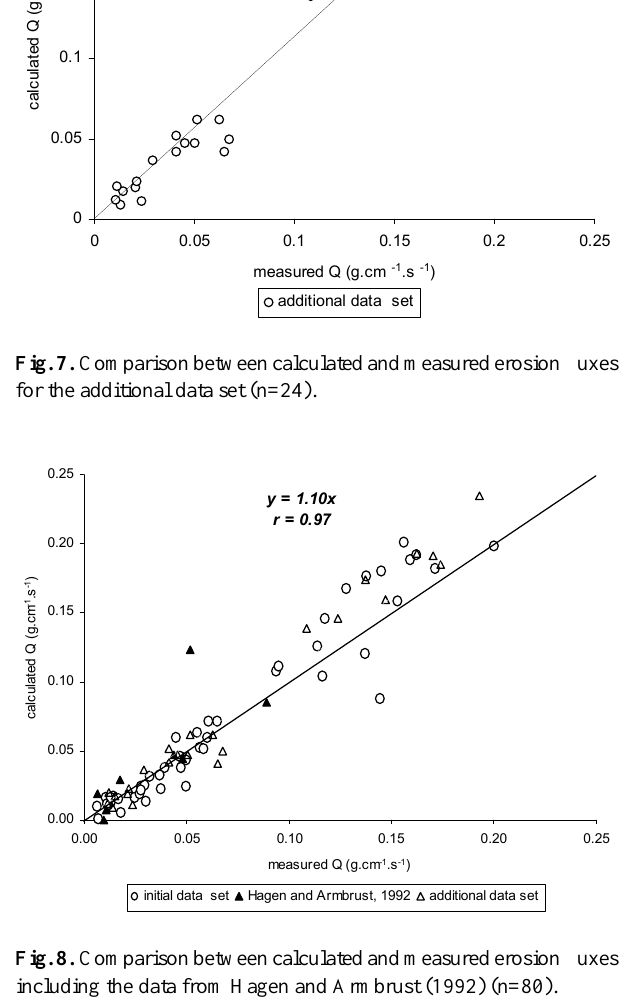
friction velocity, ( u ∗ ts ), and the adjustment coefficient, a s , were determined, as described in Sects. 3.2 and 3.3, respec- tively. Their calculated values were determined to be, respec- tively, 20.9 cm.s − 1 and 1.39.10 − 6 g.cm − 4 .s 2 . A satisfying agreement is obtained between the measured flux and the flux calculated using Eq. (3) (r=0.99; P < 0.001) (Fig. 9). A 7% error, on average, can be estimated from the slope of the